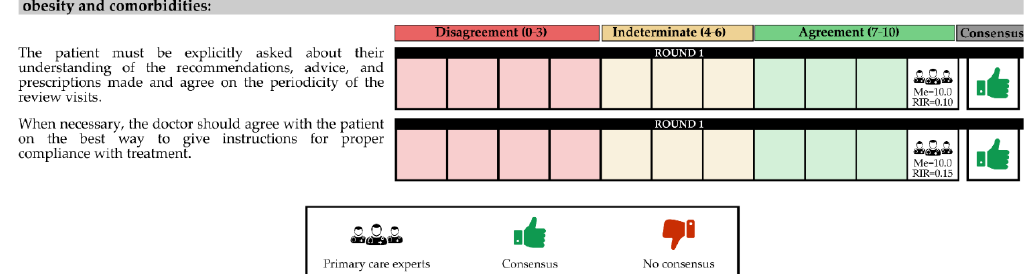
Figure 2. Discrete quantitative response questions of Block 1 under the Likert scale. IQR: Interquartile range; Me: Median.